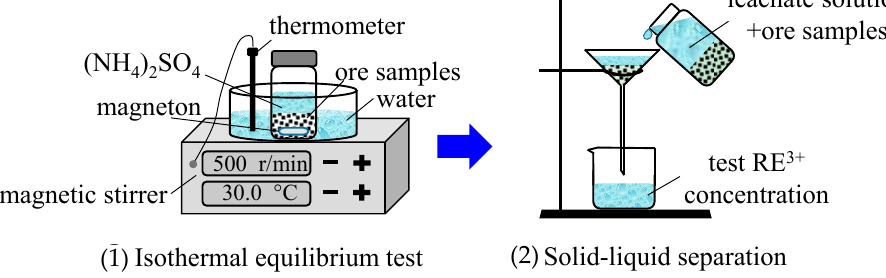
Figure 2. Schematic of the ion exchange equilibrium experiment.